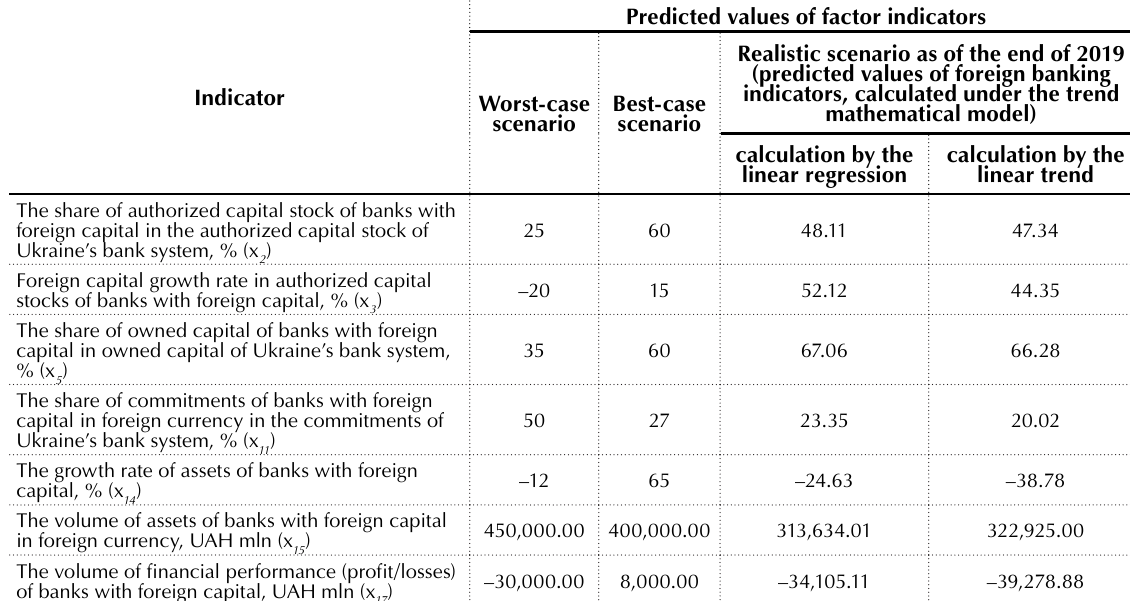
Table 3. The value of independent variables for predicting their influence on the indicators of financial and economic security of Ukraine by different